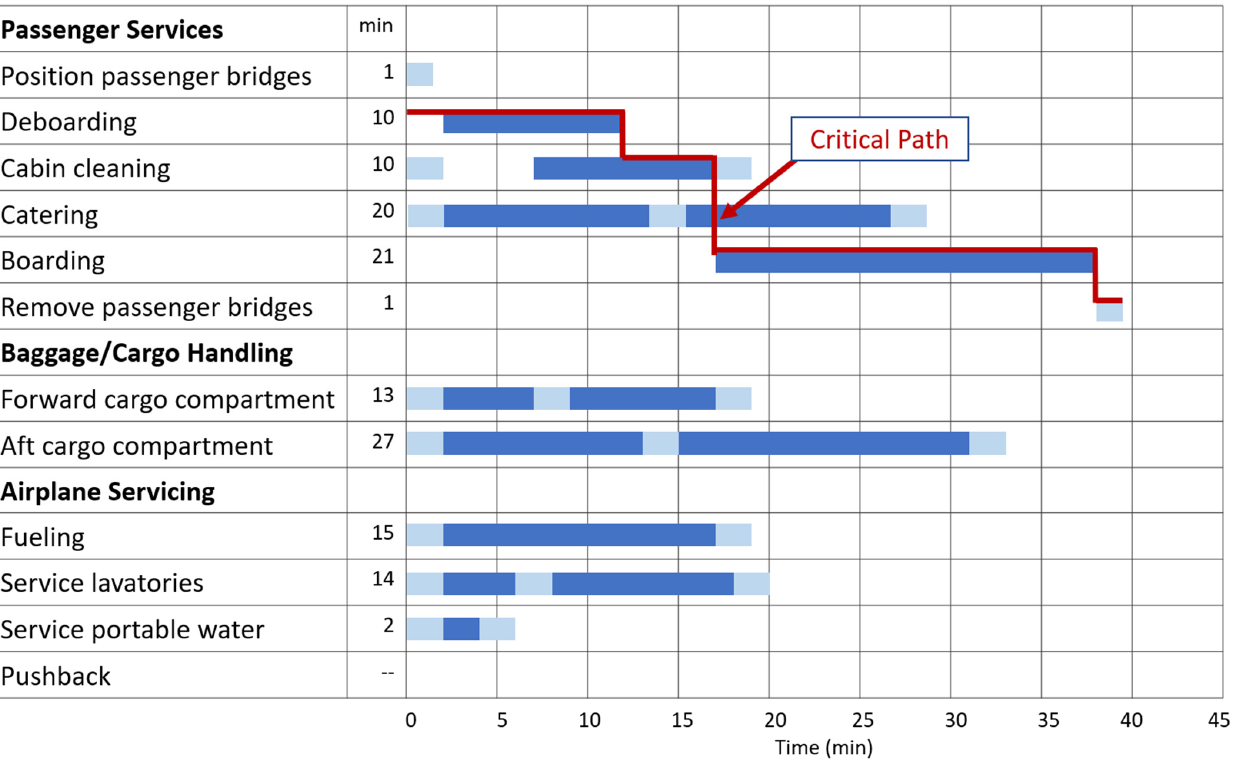
Figure 2. The air transportation system as a system of systems. Derived and adapted from Karish et al., 2019. p. 286 [4].